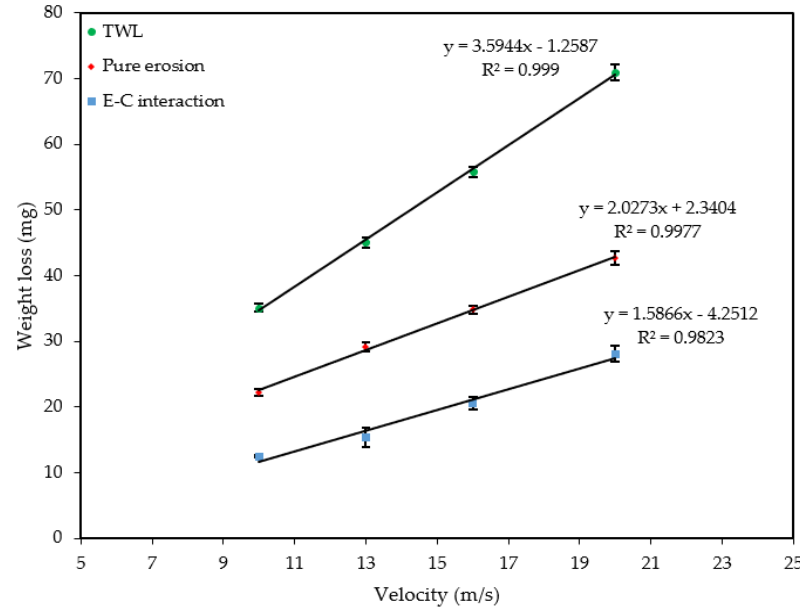
Figure 9. Effect of velocity on weight loss at 600 mg/L.